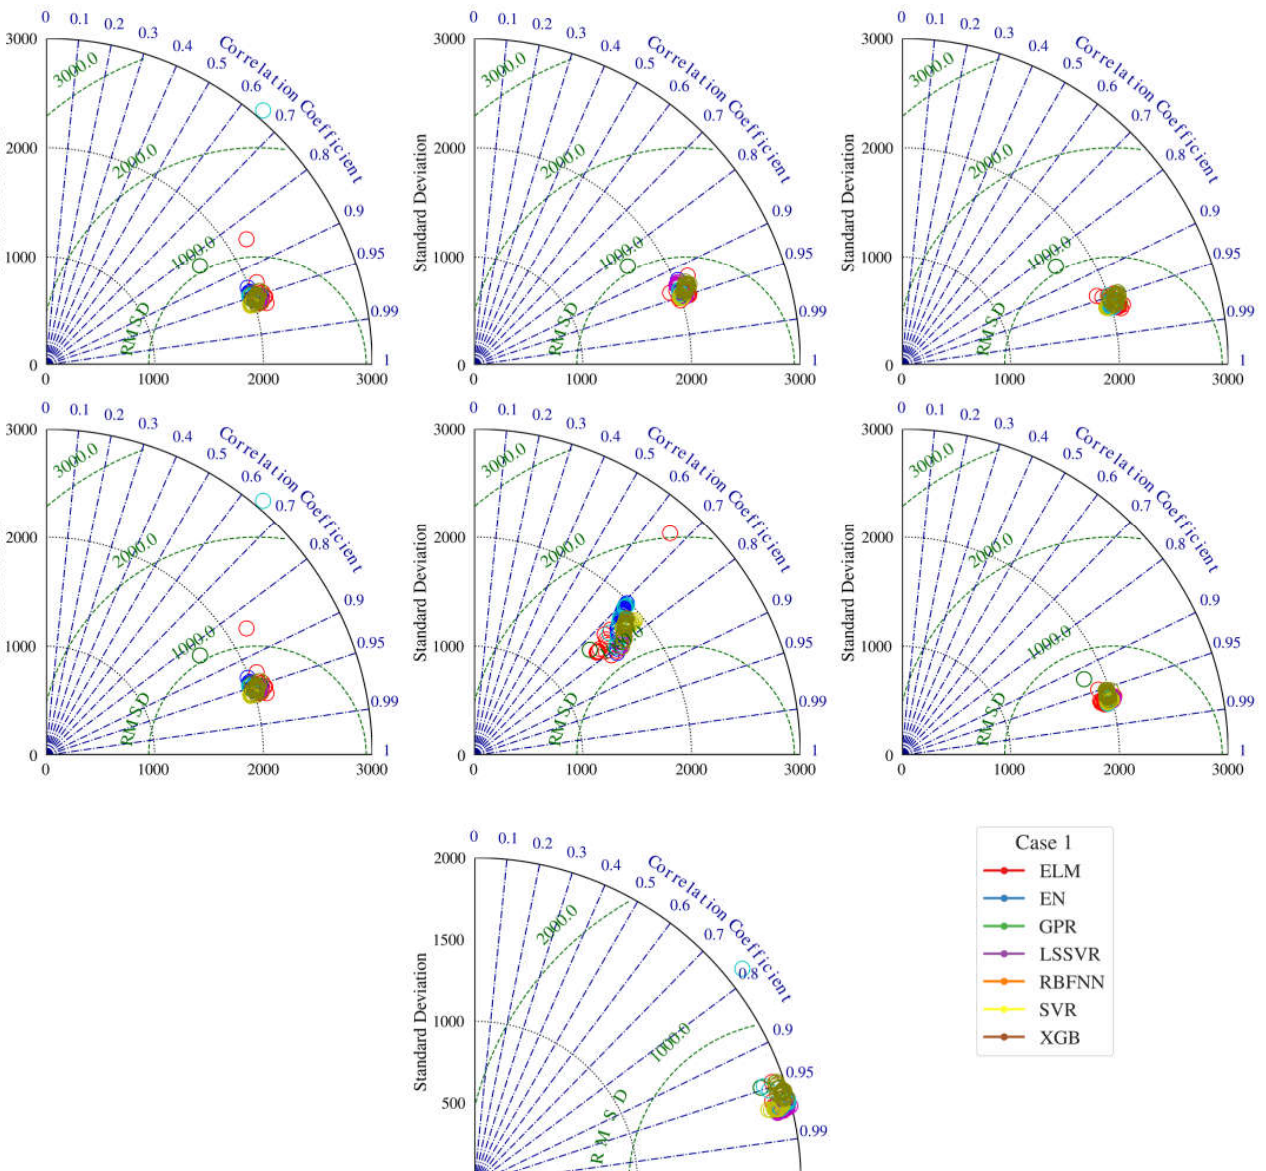
Figure 7. Taylor diagrams of the optimal models for all cases (averaged over 50 runs).